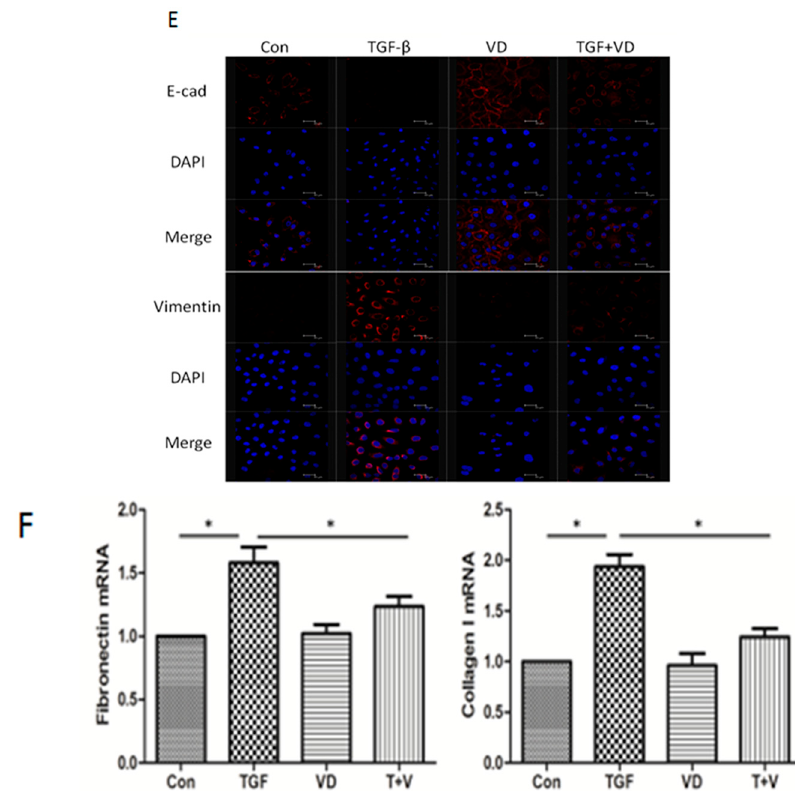
Figure 3. 1 α ,25(OH) 2 D 3 opposes the expression of EMT markers and extracellular matrix components induced by TGF- β . A549 cells were treated with 5 ng/mL TGF- β and/or 50 nmol/L 1 α ,25(OH) 2 D 3 for 72 h. ( A ) Western blot analysis of E-cadherin, N-cadherin and Vimentin. β -actin served as a loading control; ( B – D ) The levels of the indicated protein was quantified with gray value (Mean ± SD, n = 3); ( E ) Representative pictures of indicated proteins E-cadherin, Vimentin were captured by confocal laser scanner microscopy. Nuclear DNA was visualized by DAPI staining (200 × magnification); ( F ) qRT-PCR analyses of fibronectin and Collagen I (Mean ± SD, n = 3). * p < 0.05 compared with the corresponding group.